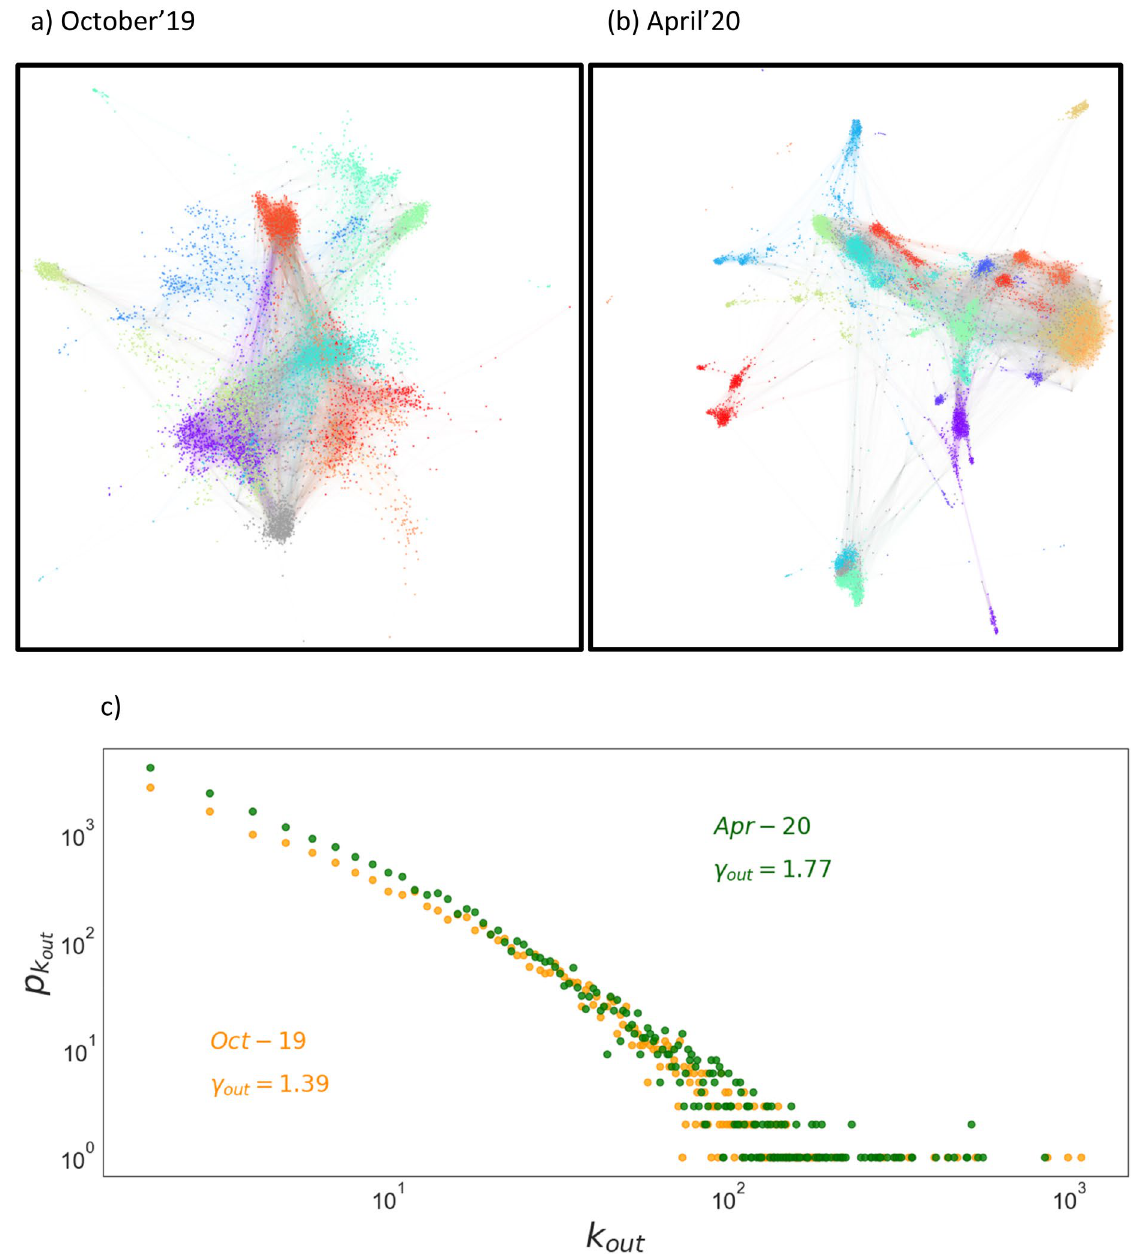
Figure 1. (a) October 2019 Twitter network. (b) April 2020 Twitter network. Each color marks those nodes corresponding with each word-of-interest subnet. Accounts in grey are the junction accounts. Links are colored with the origin node account. (c) Log–log plot of the connectivity distribution for both networks. We generate the graphs in (a,b) using the algorithm Force Atlas 2 from Gephi 22 . Force Atlas 2 is a forced-directed algorithm that stimulates the physical system to get the network organized through the space relying on a balance of forces; nodes repulse each other as charged particles while links attract their nodes obeying a Hooke’s law. So, nodes that are more distant exchange less